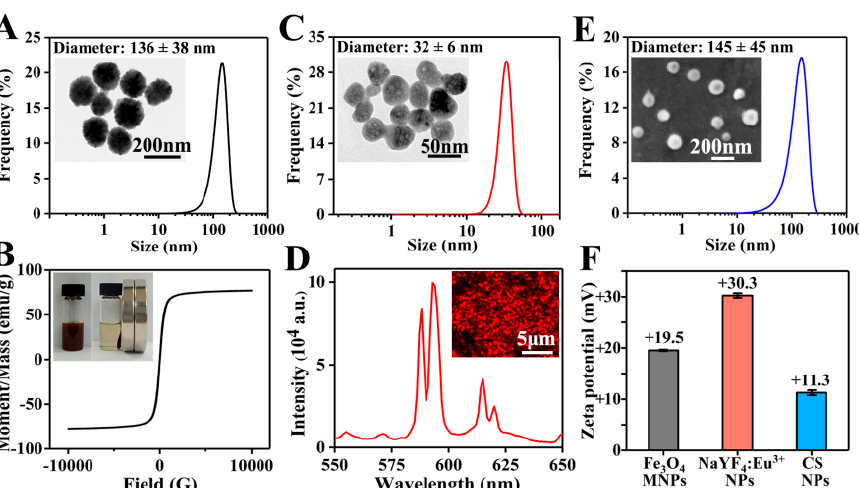
Figure 2. ( A ) TEM image and diameter distribution of Fe 3 O 4 MNPs; more than 450 Fe 3 O 4 MNPs were measured. ( B ) Hysteresis loop and magnetic responsiveness testing photographs of Fe 3 O 4 MNPs. ( C ) TEM image and diameter distribution of NaYF 4 :Eu 3+ NPs; more than 350 NaYF 4 :Eu 3+ NPs were measured. ( D ) Fluorescent microscope image and emission spectra of NaYF 4 :Eu 3+ NPs. ( E ) SEM image and diameter distribution of CS NPs; more than 400 CS NPs were measured. ( F ) Zeta potentials of Fe 3 O 4 MNPs, NaYF 4 :Eu 3+ NPs, and CS NPs.